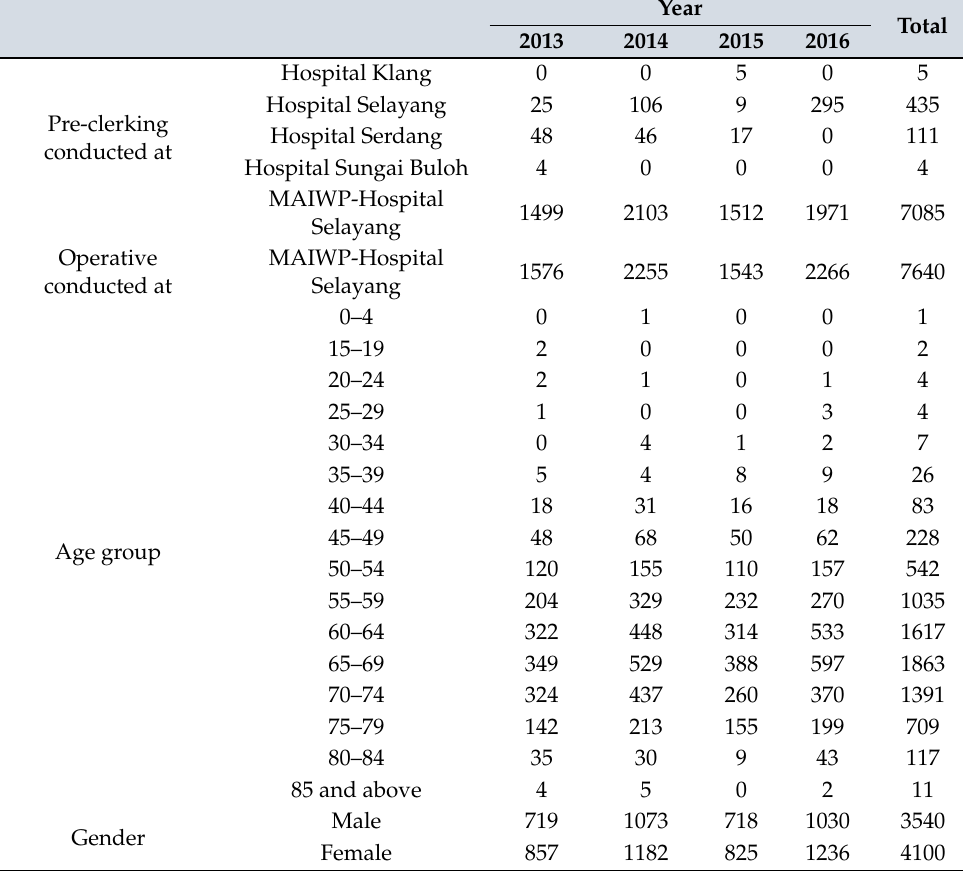
Table 1. Basic characteristics of the patients registered for cataract surgery in MAIWP-HS, from 2013 to